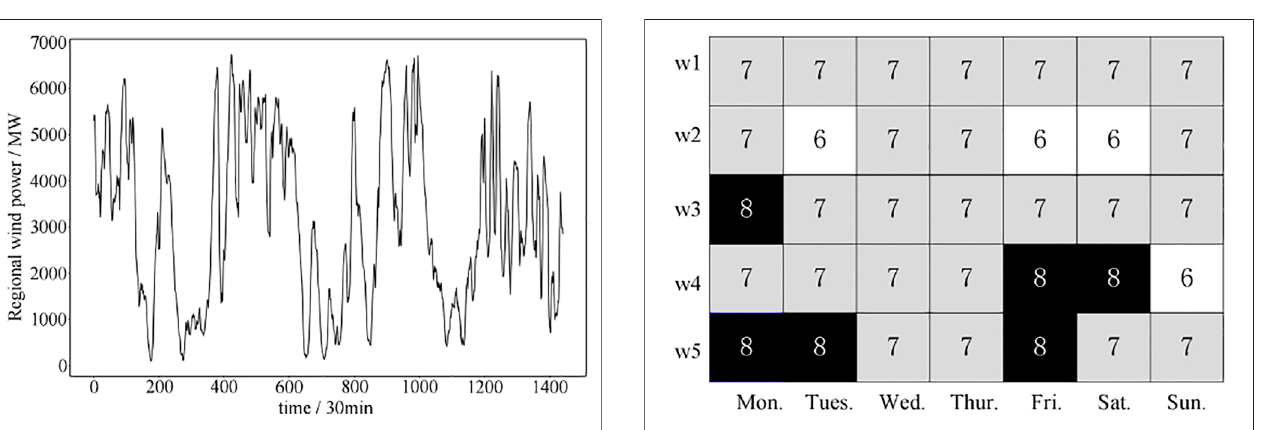
FIGURE 5 | Variation of regional wind power data.